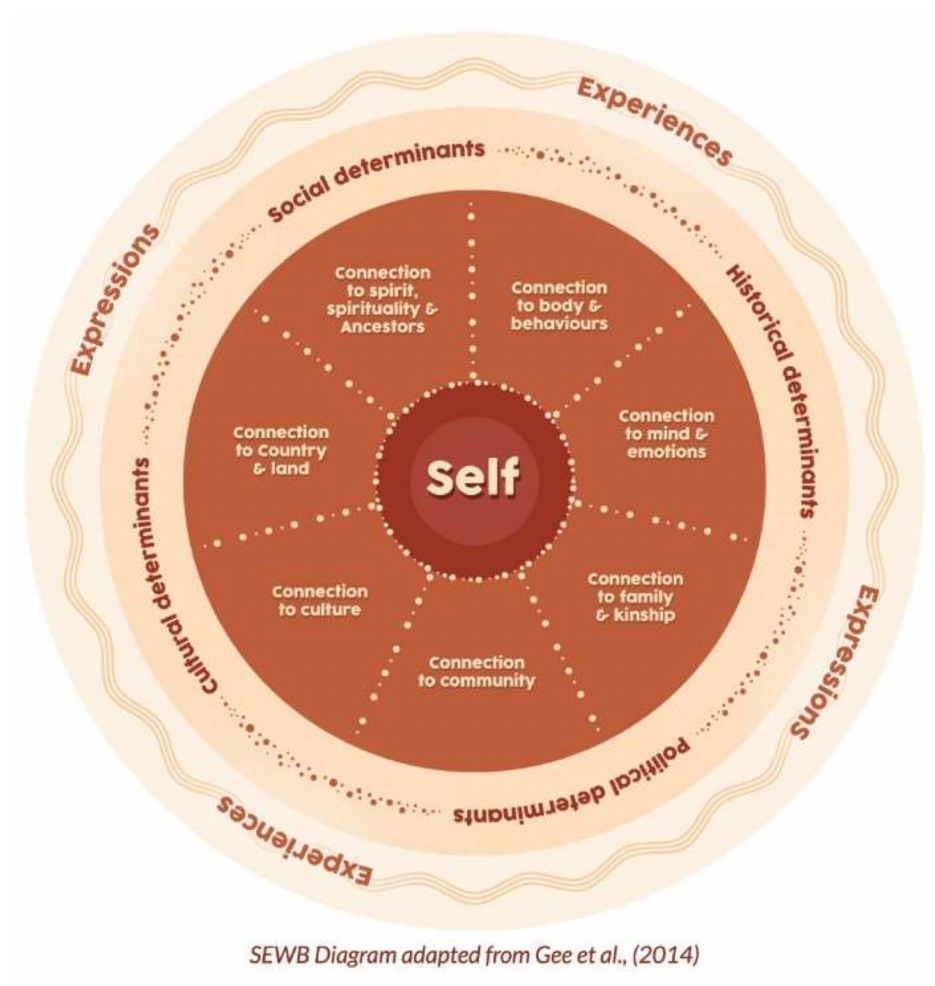
Figure 1. A visual representation of social and emotional wellbeing